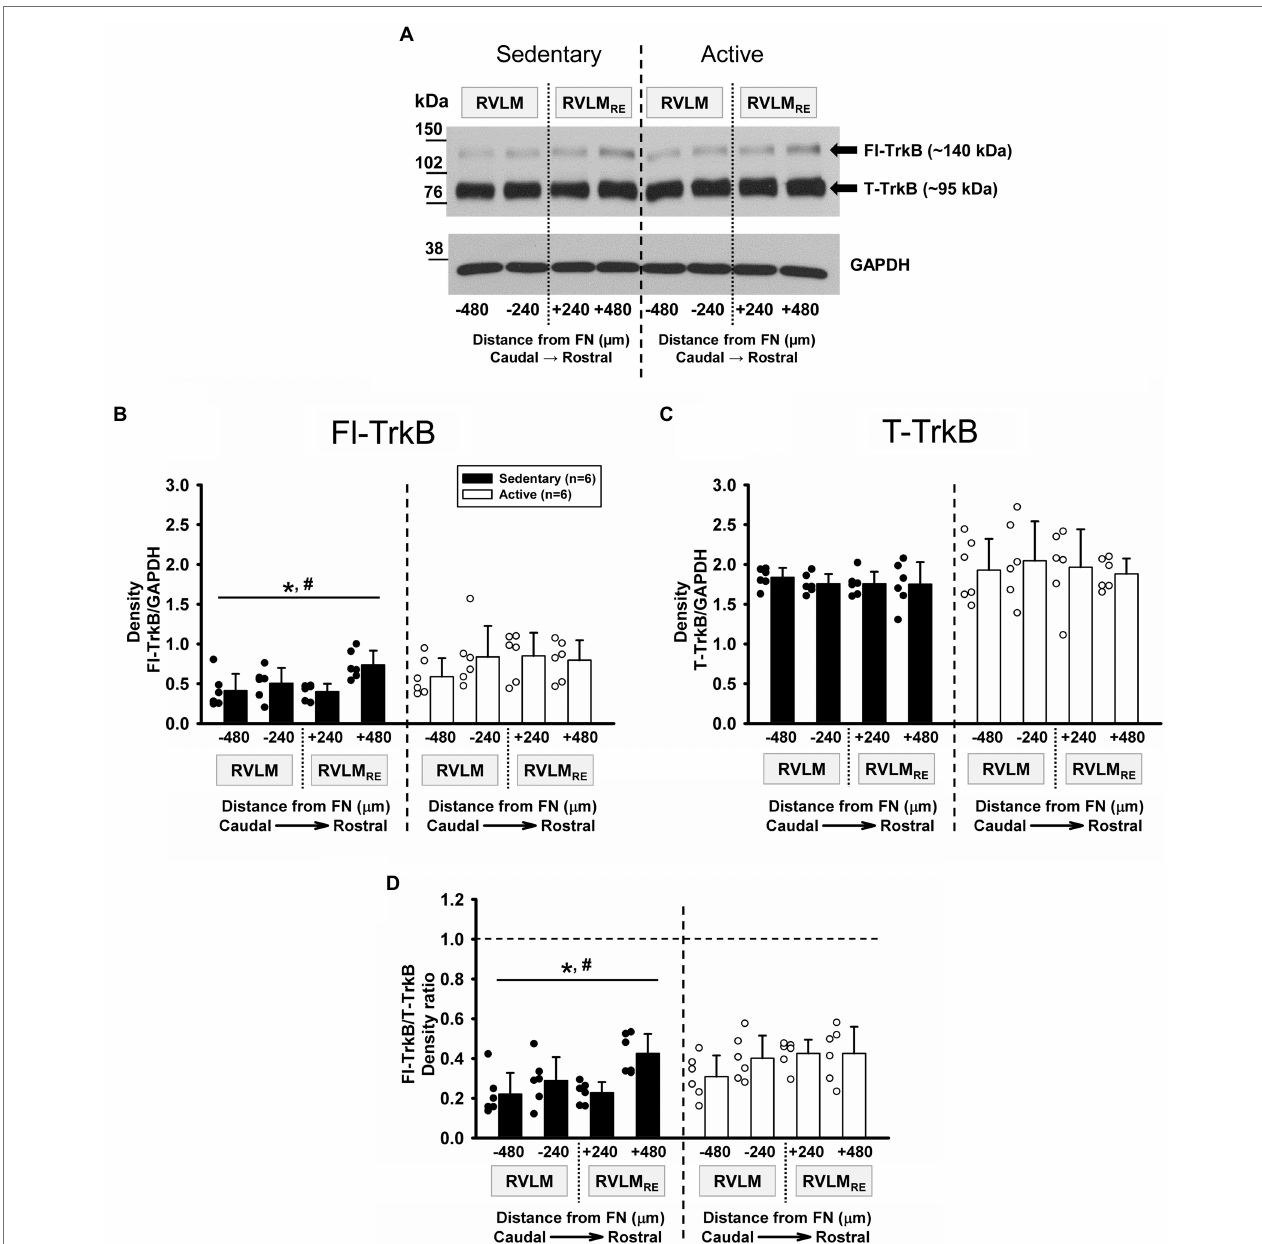
FIGURE 4 | Expression of TrkB receptor isoforms in the RVLM/RVLM RE following 10–12 weeks of sedentary vs. physically active conditions. (A) Representative Western blot of Fl-TrkB (arrow ~140 kDa) and T-TrkB (arrow ~95 kDa) isoforms, and GAPDH expression (probed on same membrane) at different rostrocaudal levels of the RVLM and the RVLM RE . (B) Group data from sedentary (black bars) vs. physically active (white bars) conditions ( n = 6 ea) demonstrate an overall significantly lower expression of Fl-TrkB in sedentary compared to physically active animals [*, F (1, 30) = 9.842, p = 0.011, main effect of group]. There was also a main effect of rostrocaudal distribution [#, F (3,30) = 3.967, p = 0.017, see Supplementary Table S2 for all simple main effect comparisons]. The lack of significant interaction between experimental groups and rostrocaudal levels [ F (3,30) = 1.928, p = 0.146] precluded further post hoc test testing. (C) Group data demonstrating no significant overall difference in the expression of T-TrkB in sedentary compared to active animals [ F (1, 30) = 1.345, p = 0.273, main effect of group]. Neither a main effect of rostrocaudal distribution nor an interaction between groups and rostrocaudal levels reached significance [ F (3,30) = 0.425, p = 0.737 and F (3,30) = 0.601, p = 0.619, respectively]. (D) Group data demonstrating a significantly lower Fl-TrkB/T-TrkB ratio in sedentary compared to active rats [*, F (1,30) = 7.029, p = 0.024, main effect]. A significant overall effect of rostrocaudal distribution on the Fl-TrkB/T-TrkB ratio suggested a lower ratio of expression in the caudal RVLM and higher expression in the rostral RVLM RE [#, F (3,30) = 6.080, p = 0.002; main effect; see Supplementary Table S2 for rostrocaudal comparisons within collapsed groups]. The lack of significant interaction between main effects [ F (3,30) = 2.303, p = 0.097] precluded further post hoc testing. Statistical results are from two-way mixed ANOVAs with lines and individual symbols (*. #) denoting significant main effects. Data in (B) were log10 transformed in order to achieve normal distribution prior to running two-way mixed